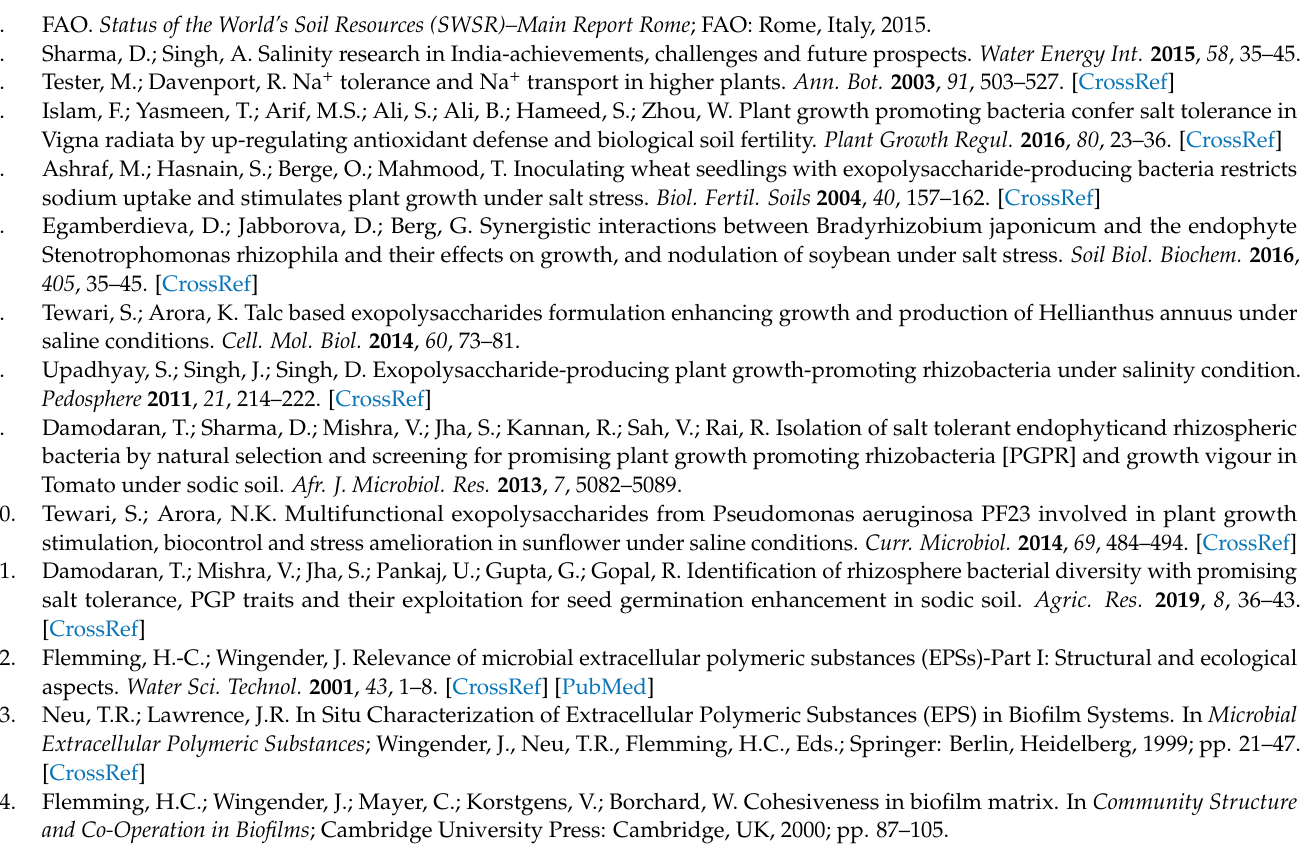
Figure S4: Principal component analysis plots relating biofilm-forming ability and EPS-producing sodic-tolerant bacterial isolates; Table S1: Soil properties of collected sodic soils; Table S2: Bacteria isolated from the rhizosphere of rice under sodic soils; Table S3: Selection of sodium